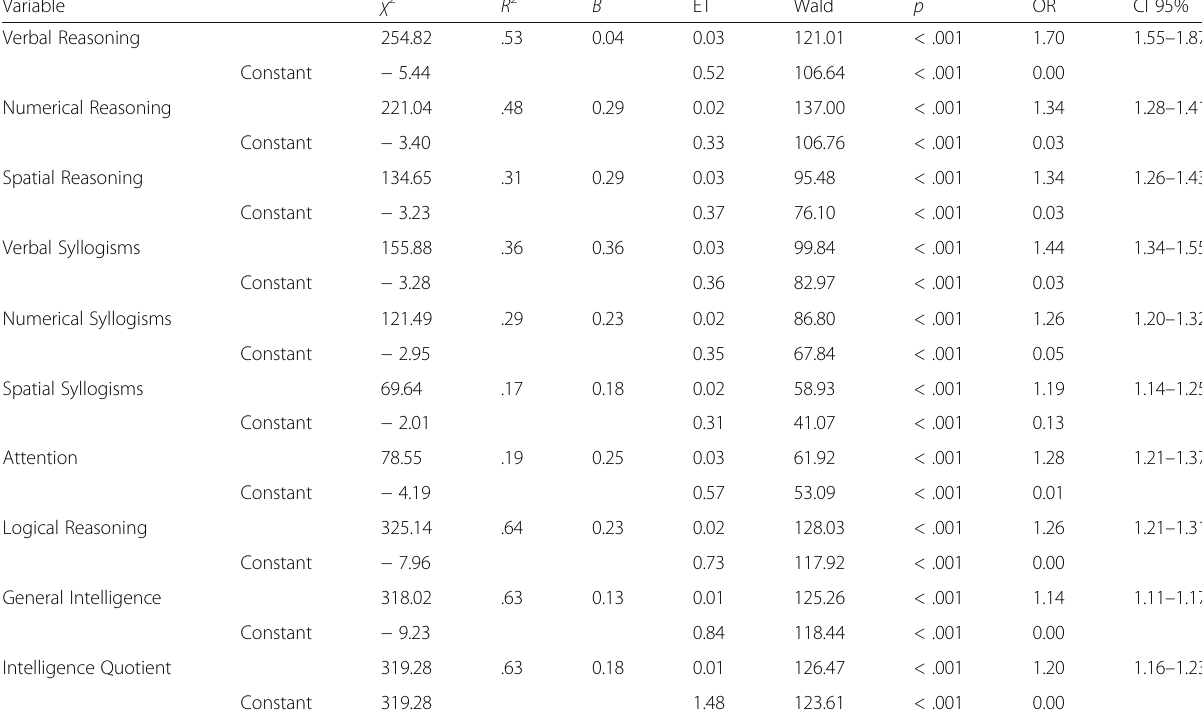
Table 4 Logistic regression for the predictive probability of each one of the cognitive aptitudes of BADYG-E2 and the student not dropping the instrumental subject of